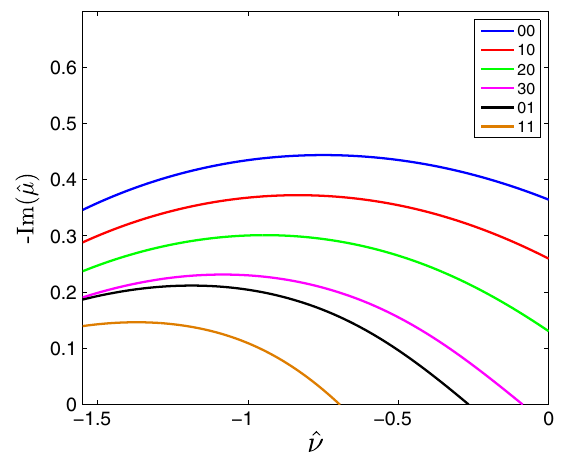
FIG. 6. Negative imaginary part of the scaled FEL growth rate ˆ μ as a function of the scaled detuning ˆ ν for various FEL modes (data for the η ¼ 4 mm case, derived from the analytical